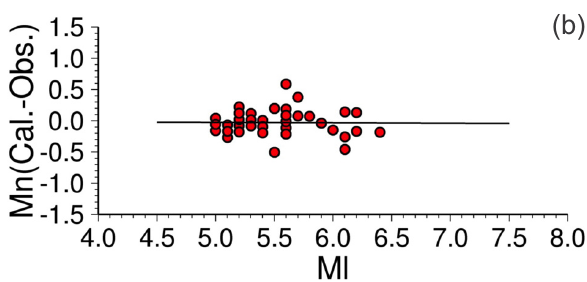
- M relation for 48 Persian earthquakes (red dots); Figure 6. (a) M N L (b) credibility test for this